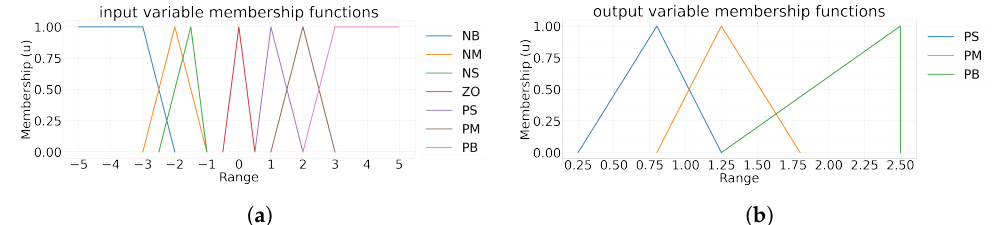
Figure 13. ( a ) Input Membership Function of e [ t ] for the APS. ( b ) Output Membership Function of e [ t ] for the APS.